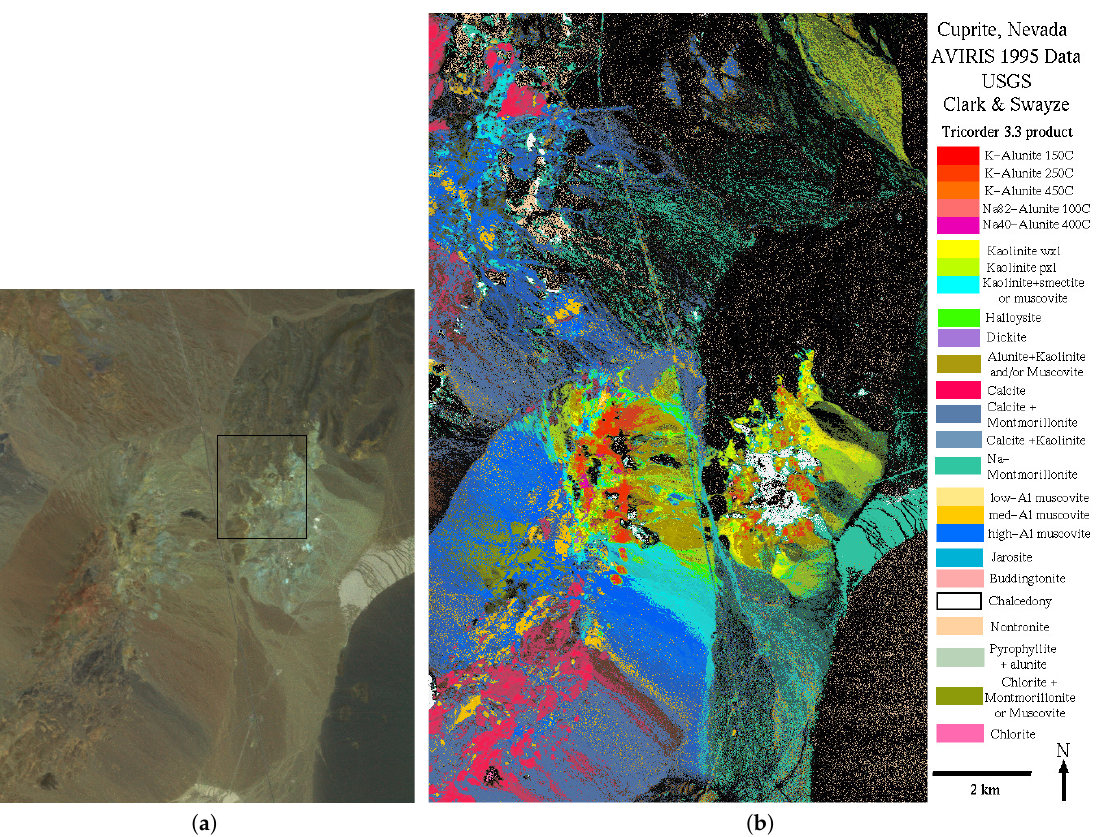
Figure 6. ( a ) Cuprite data generated in pseudocolor. Black rectangle shows area of our experiment; ( b ) USGS mineral distribution map of Cuprite mining district in Nevada